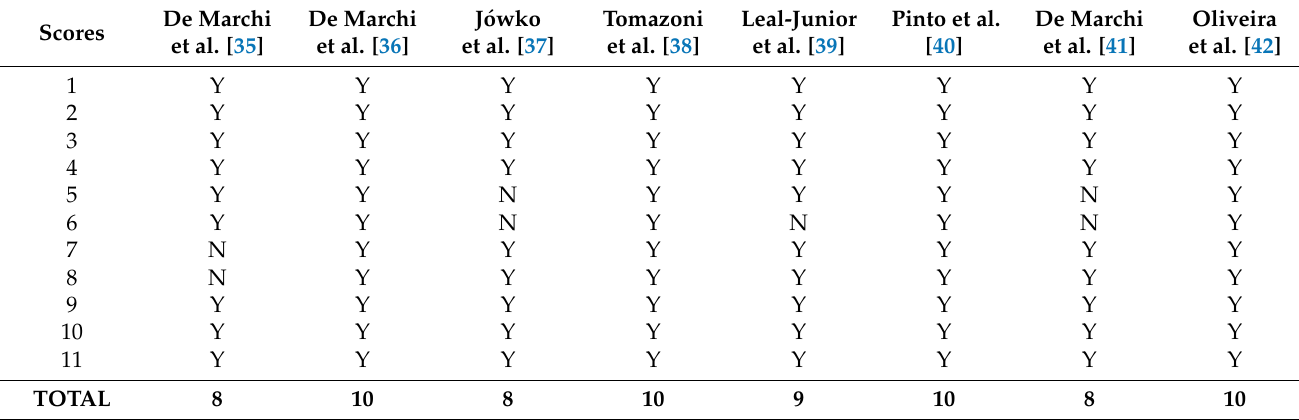
Table 3. Risk of Bias (PEDro